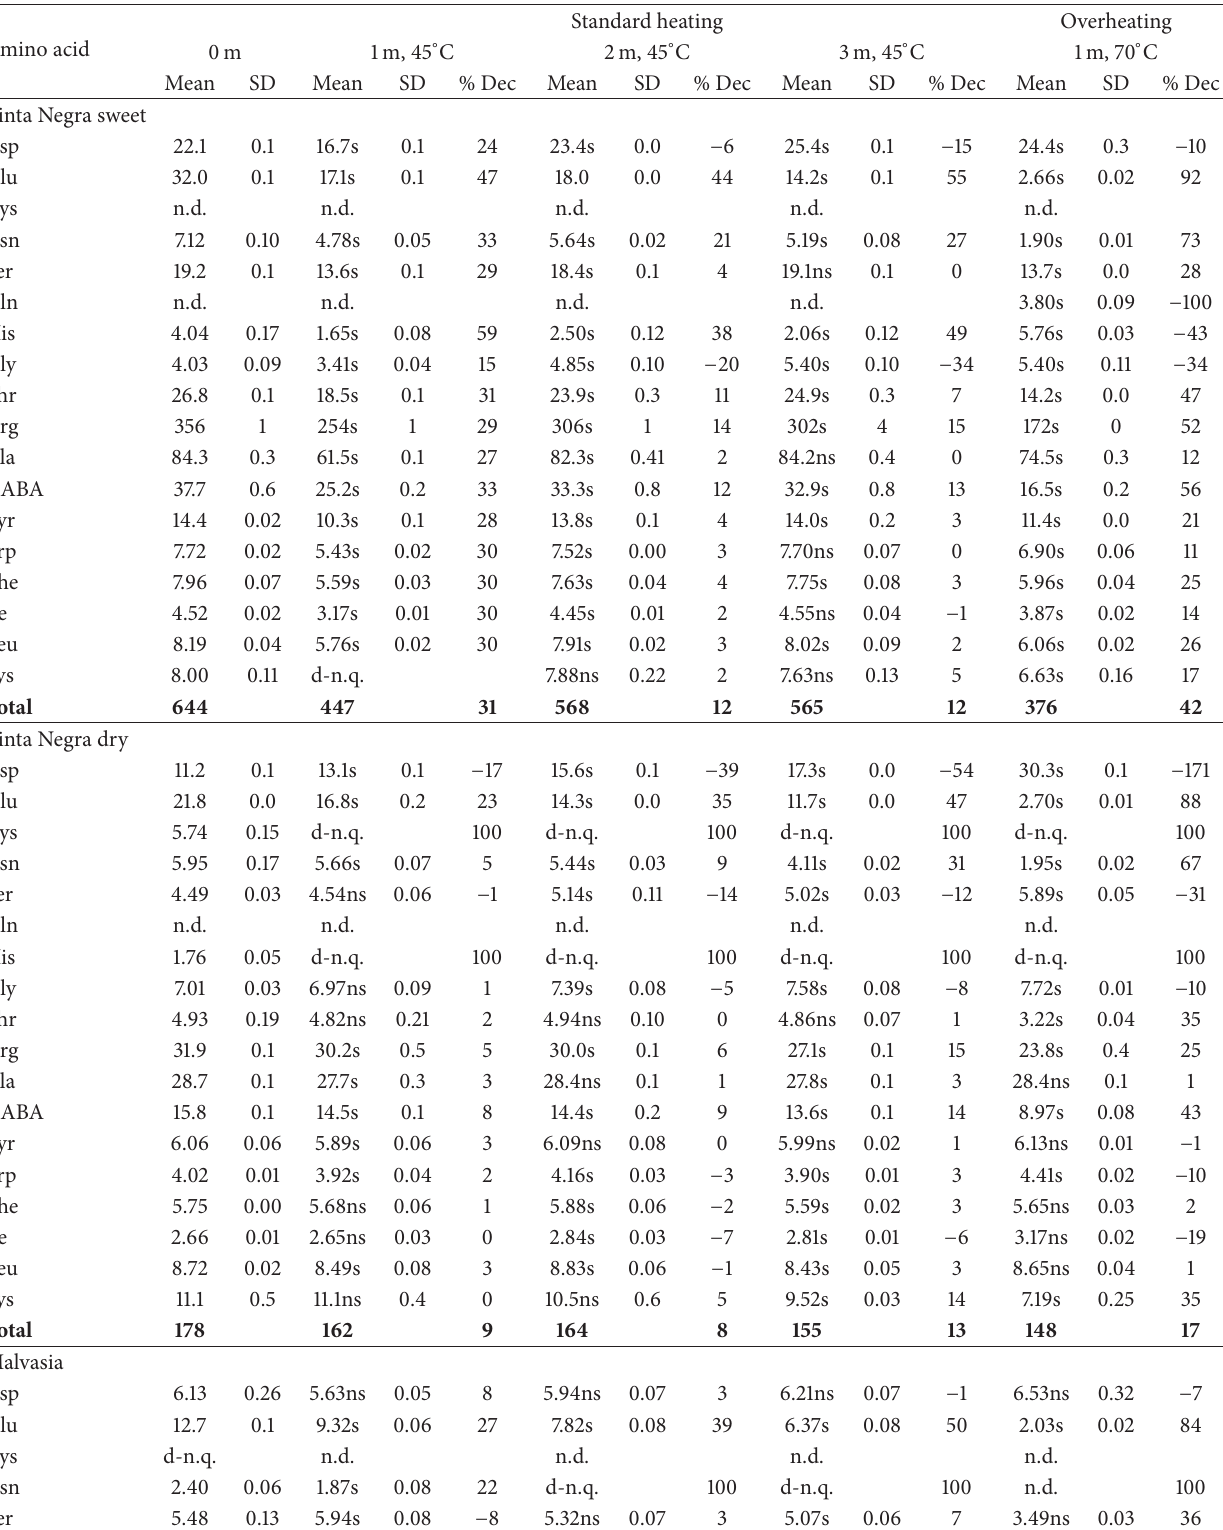
Table 2: Contents of the amino acids found in the current Madeira wines at different wine stages: initial (0m), after 1, 2, and 3 months at 45 ∘ C (standard heating), and after 1 month at 70 ∘ C (overheating). The results are expressed in mg/L as mean ± standard deviation (SD). The percentage of decrease (% Dec) of each compound relative to the initial value is also